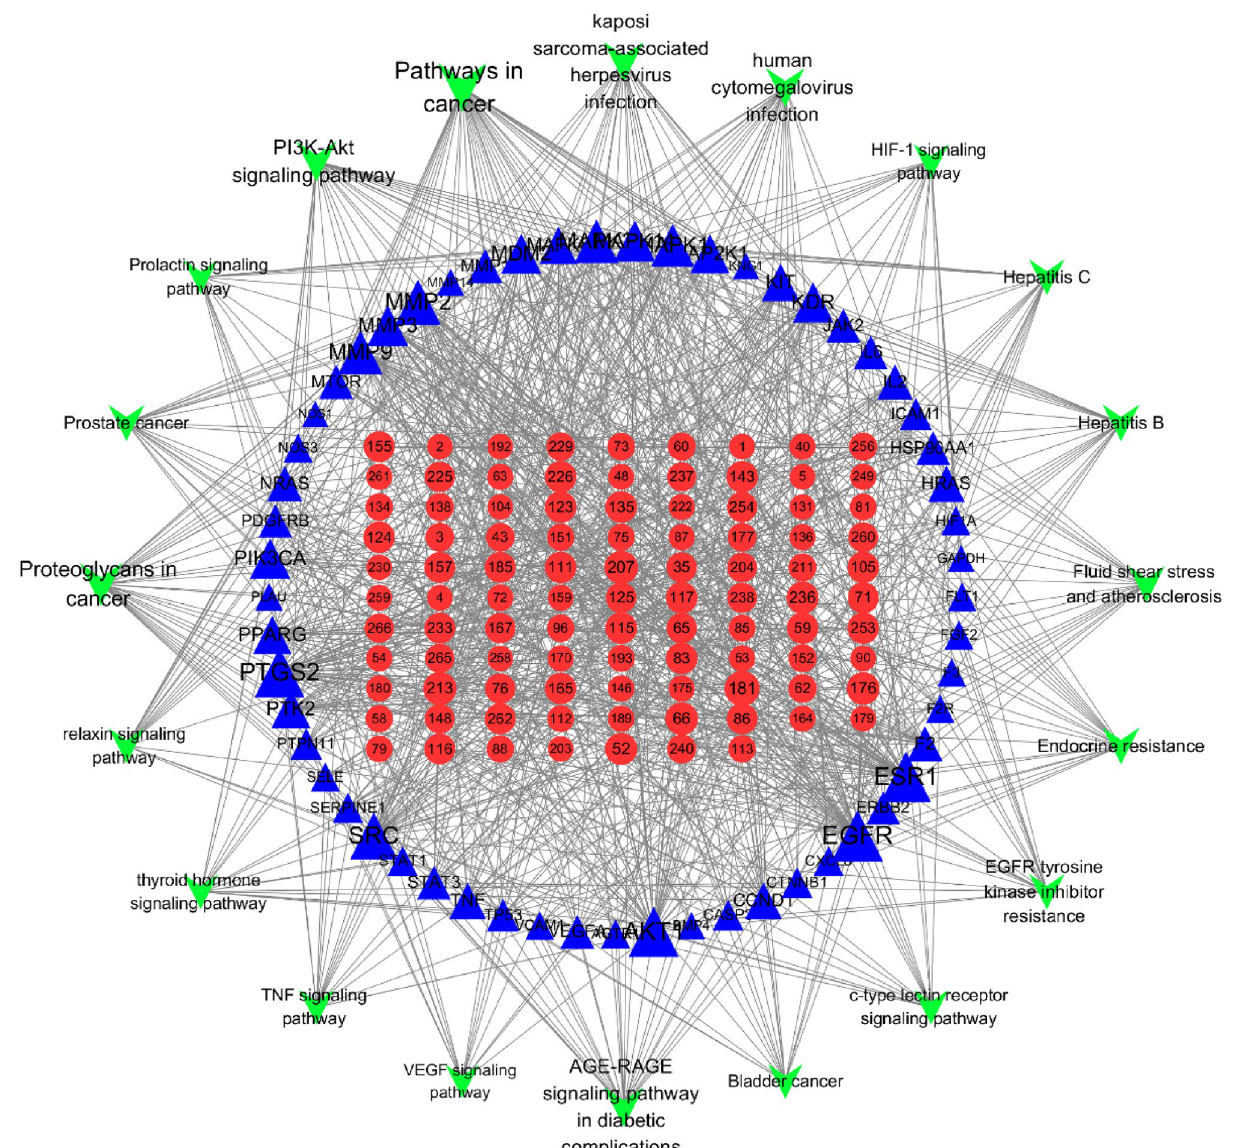
Figure 9. Component-target-pathway network comprised 190 nodes and 1042 edges. The red circular nodes represent 97 identified components of JSHX, the blue triangle nodes represent 57 PF-related targets, and the green V-shaped nodes represent the top 20 enriched KEGG pathways, and the node size is related to the degree value, the larger the degree value, the larger the node. The edges represent interactions between components, targets, and pathways [this figure was drawn by the Cytoscape (version